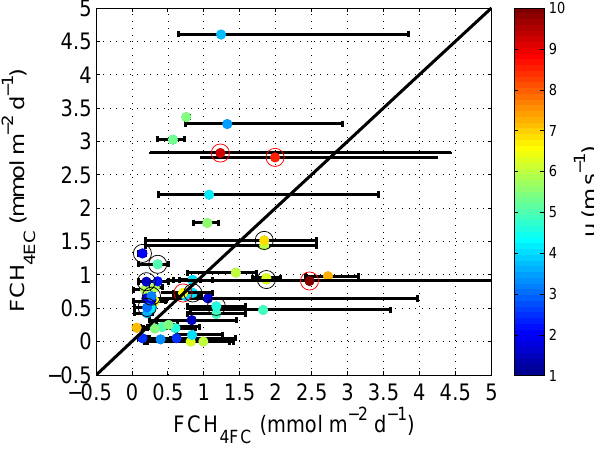
Figure 2. Time series of FCH 4EC1 black dots, FCH 4EC2 blue dots and FCH 4FC red dots (only FCs with 30min deployment times po- sitioned in EC1 footprint). The bars on FCH 4FC represent the max- imum and minimum FCH 4FC from the individual chambers during one deployment.